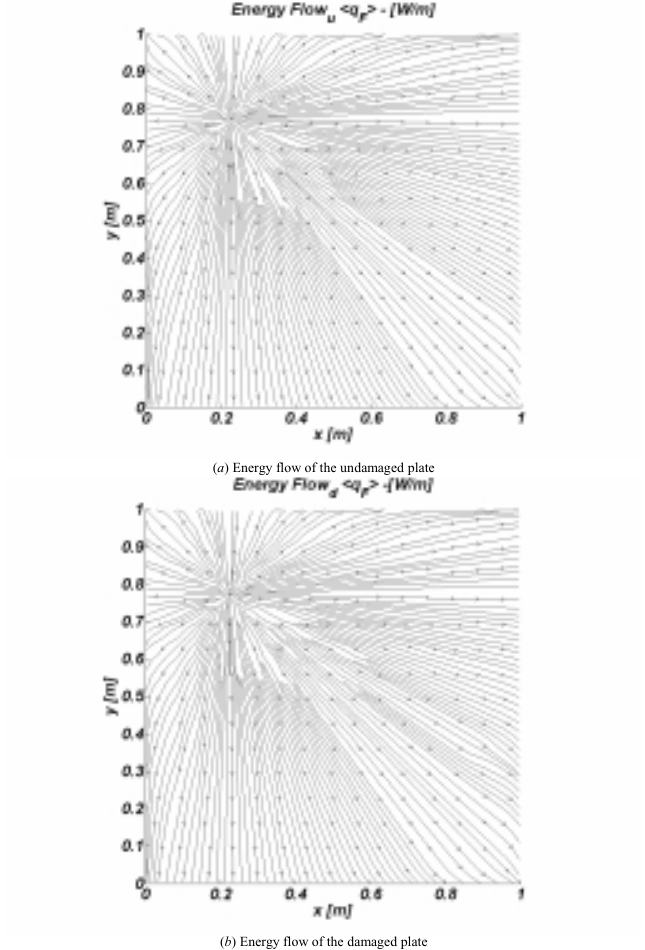
Fig. 12. Flexural energy flow by EFEM: (a) without damage and (b) with 1% damage in element 24 and 50% damage in element